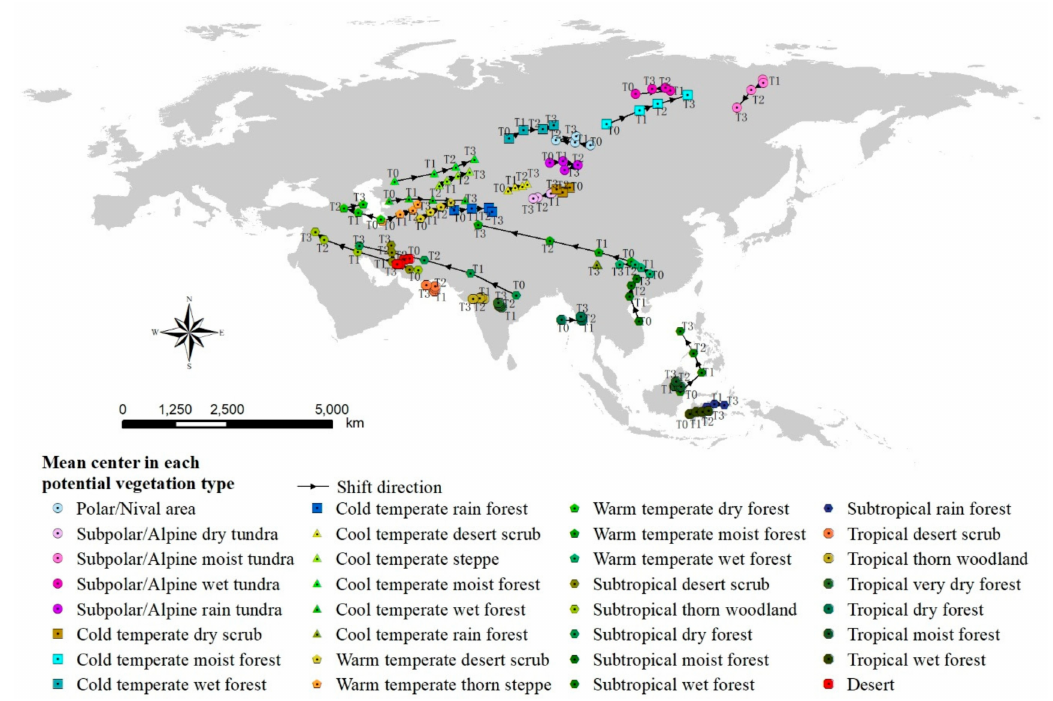
Figure 3. Shift trends of the mean centers of each potential vegetation type under the RCP2.6 scenario in Eurasia. Table 3. Shift distances (km) and directions of the mean centers of each potential vegetation type under the RCP4.5 scenario in